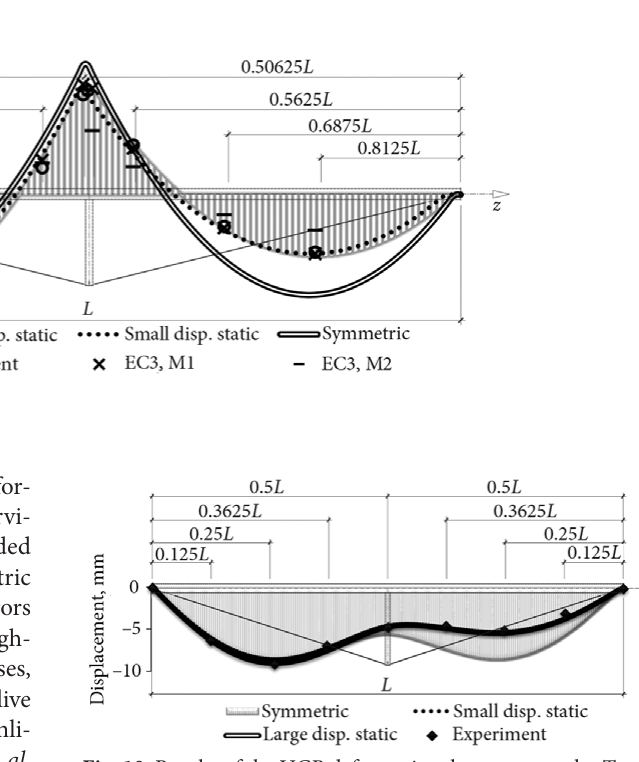
Fig. 10. Results of the UGB deformational response under Test